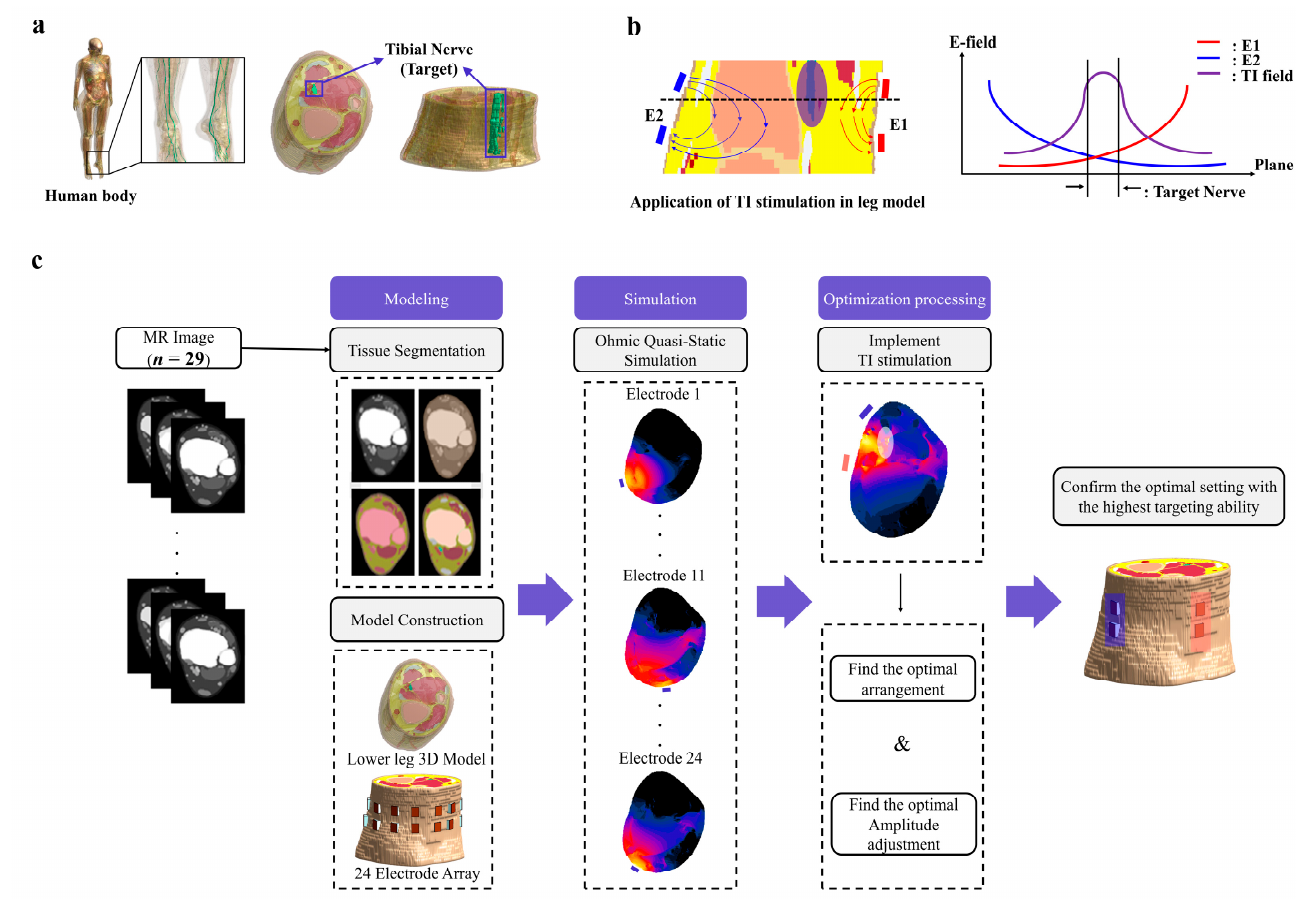
Figure 1. Concept of TI current stimulation on the tibial nerve and optimization of the TI stimulation framework. ( a ) Position of the target area (tibial nerve) in the human phantom model (left) and the target area in the MR-based 3D model (right). ( b ) Concept of applying TI stimulation to the peripheral region. ( c ) Overall processing for TI stimulation